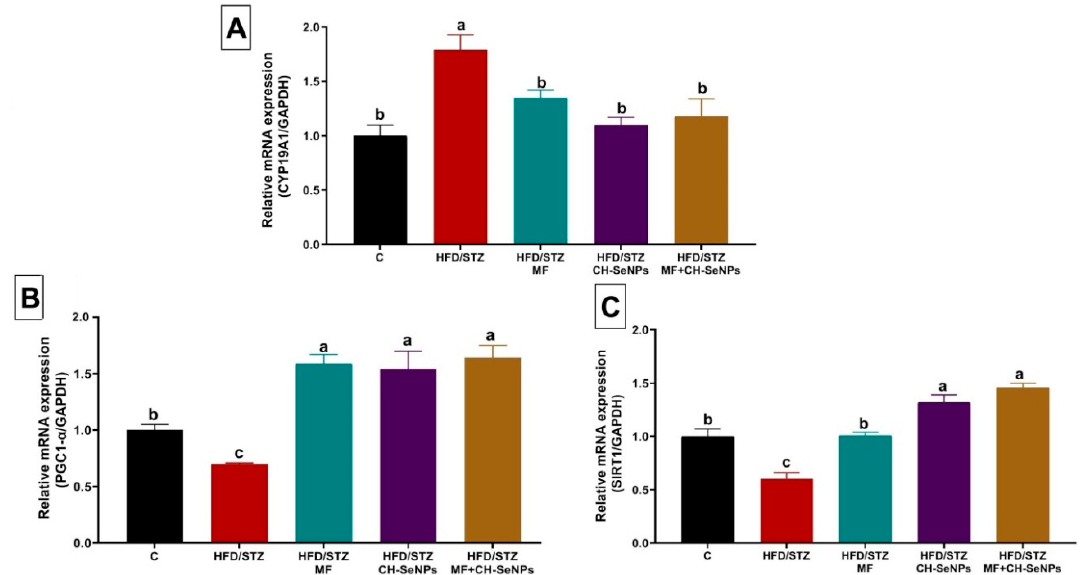
Figure 5. Effect of metformin (MF) and/or chitosan stabilized nanoparticles (CH-SeNPs) oral dosing for 60 days on mRNA expression of ( A ) aromatase gene (CYP19A1), ( B ) peroxisome proliferator-activated receptor gamma coactivator 1-alpha (PGC-1 α ), and ( C ) Silent information regulator type-1 (SIRT1) in the testicular tissues of HFD/STZ diabetic male rats. Data expressed as mean ± SE, n = 15 for each group. Each bar carrying different letters (a, b, c, and d) was significantly different at p < 0.05.